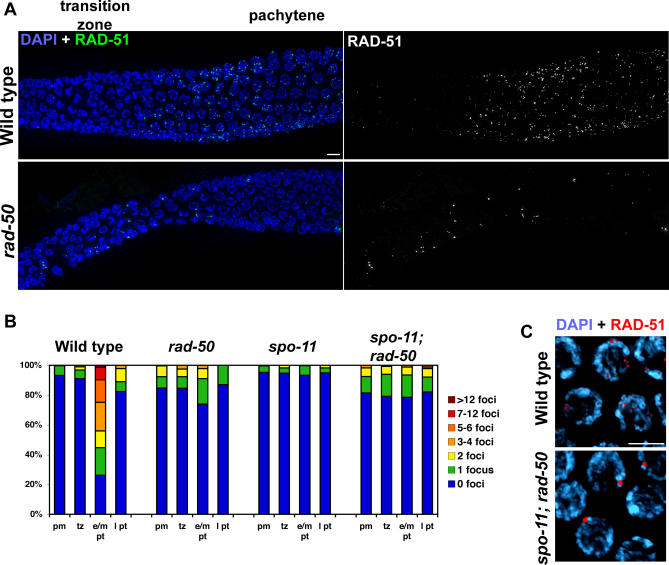
Altered Profile of RAD-51 Foci in rad-50 Mutant Germ Lines(A) Images show a portion of the germ lines of wild type and rad-50 mutant hermaphrodites, extending from the premeiotic region in which nuclei have not yet entered meiotic prophase (left) through the region of meiotic prophase entry (transition zone) and into the pachytene region (in which chromosomes are fully paired and synapsed; right). Chromosomes are stained with DAPI and RAD-51 antibody. In the wild-type germ line, RAD-51 foci are very infrequent in premeiotic and transition zone nuclei, but are abundant in pachytene nuclei, with multiple foci in the majority of nuclei. In the rad-50 mutant germ line, the number of foci in premeiotic and transition zone nuclei is elevated, while the number of foci in pachytene nuclei is severely reduced. Scale bar = 5 μm.(B) Quantitative time course analysis of RAD-51 foci. Stacked bar graph depicting quantitation of RAD-51 foci in premeiotic nuclei (pm), transition zone nuclei (tz), early-mid pachytene nuclei (e/m pt), and late pachytene nuclei (l pt) in gonads of the indicated genotypes. Different colored segments represent the percentage of nuclei scored that had the numbers of RAD-51 foci indicated by the color code at the right of the graph.(C) High magnification view of pachytene nuclei from wild type and spo-11; rad-50 germ lines. Whereas the RAD-51 foci in the wild-type pachytene nuclei are more numerous, the SPO-11-independent RAD-51 foci in the spo-11; rad-50 nuclei are larger/brighter. Scale bar = 5 μm.